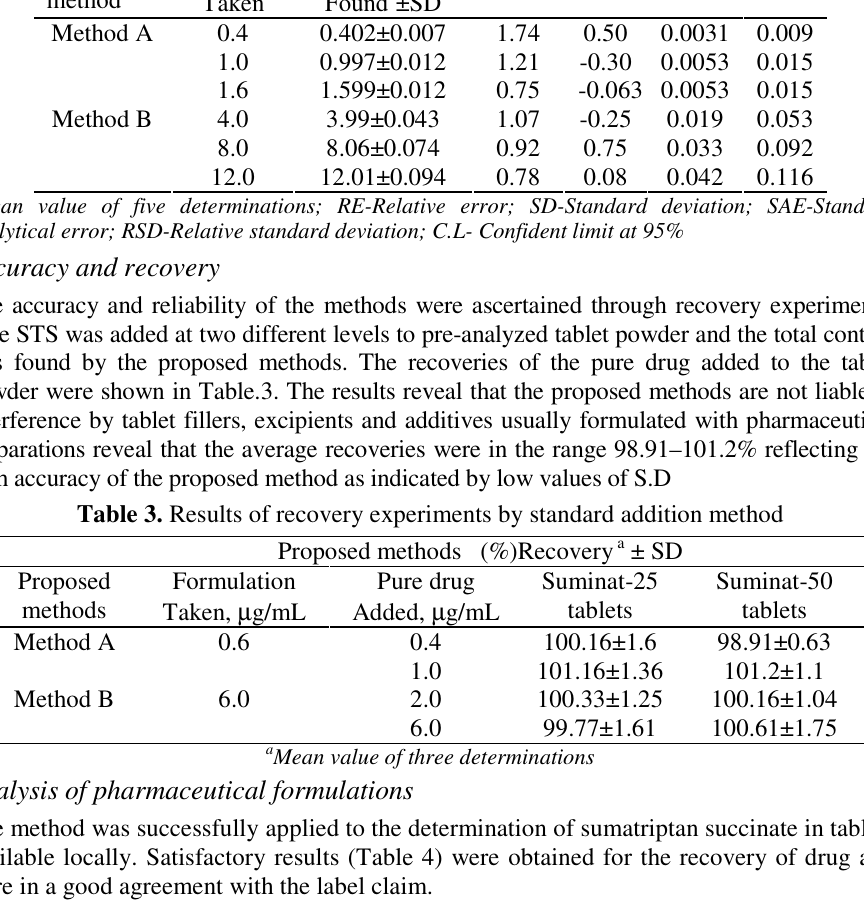
Table 4. Results of determination of sumatriptan succinate in